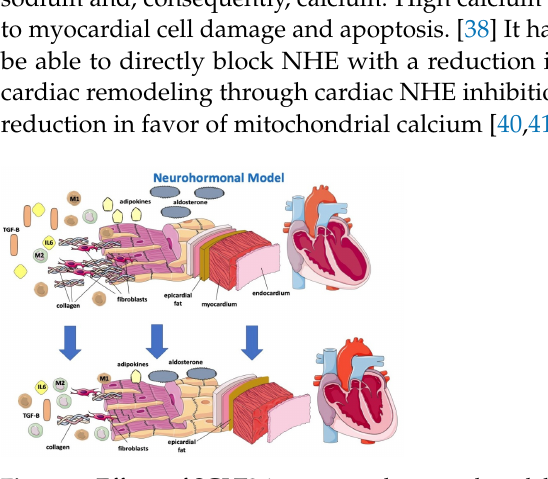
Figure 2. Effects of SGLT2-i on a neurohormonal model and on inflammatory markers.